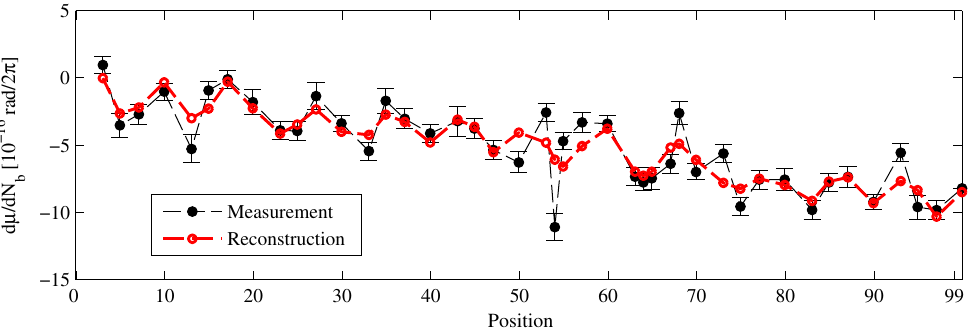
FIG. 9. Comparison between measured and reconstructed phase advance slope as a function of the BPM position along the machine circumference. The horizontal unit represents the straight section number in the PS